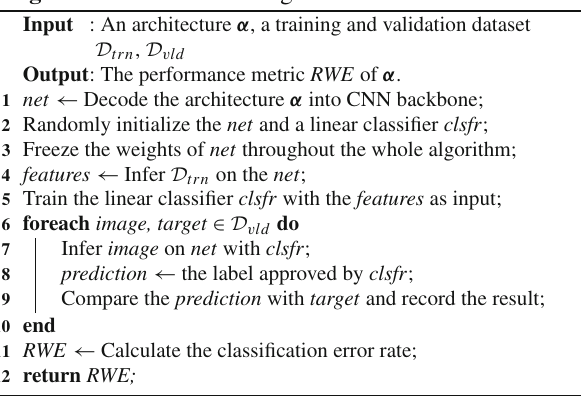
Algorithm 1: Random-Weight